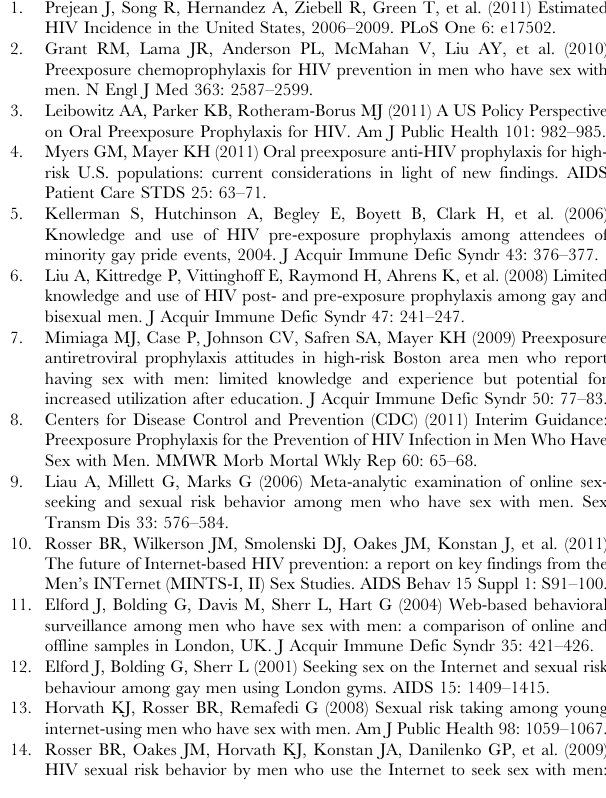
No UAI with male partner